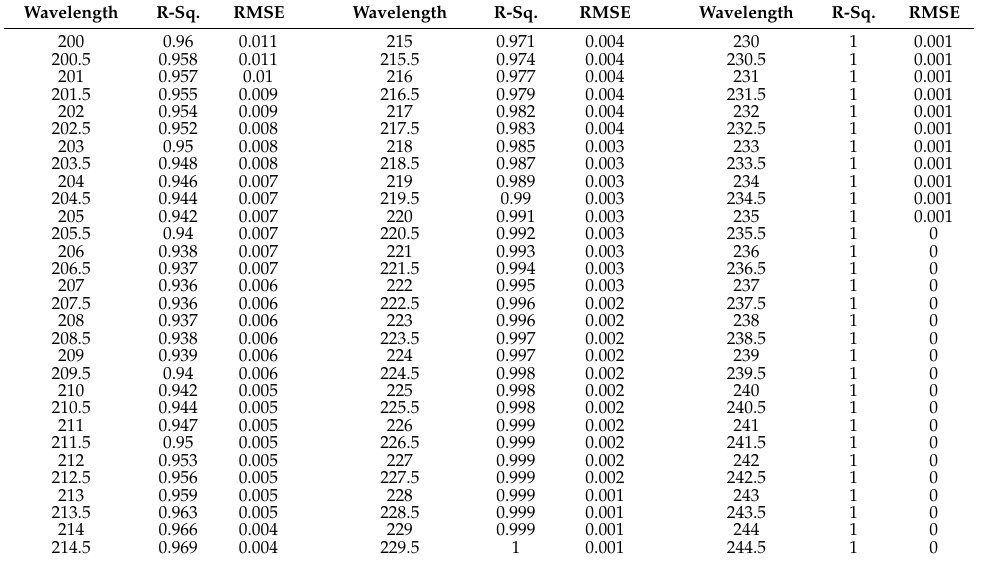
Table A1. R-Square and RMSE values in linear model fit between ∆ 245, ultrapure and ∆ i, ultrapure .